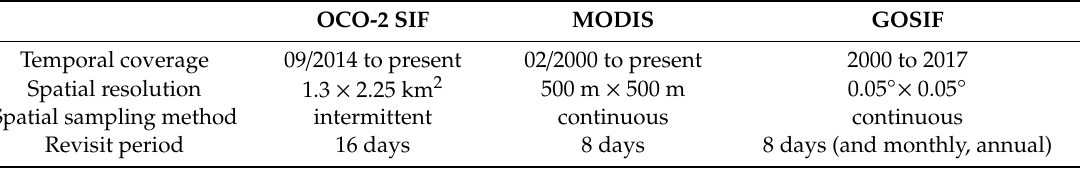
Table 2. Basic information of the OCO-2 sun-induced chlorophyll fluorescence (SIF), MODIS, and GOSIF